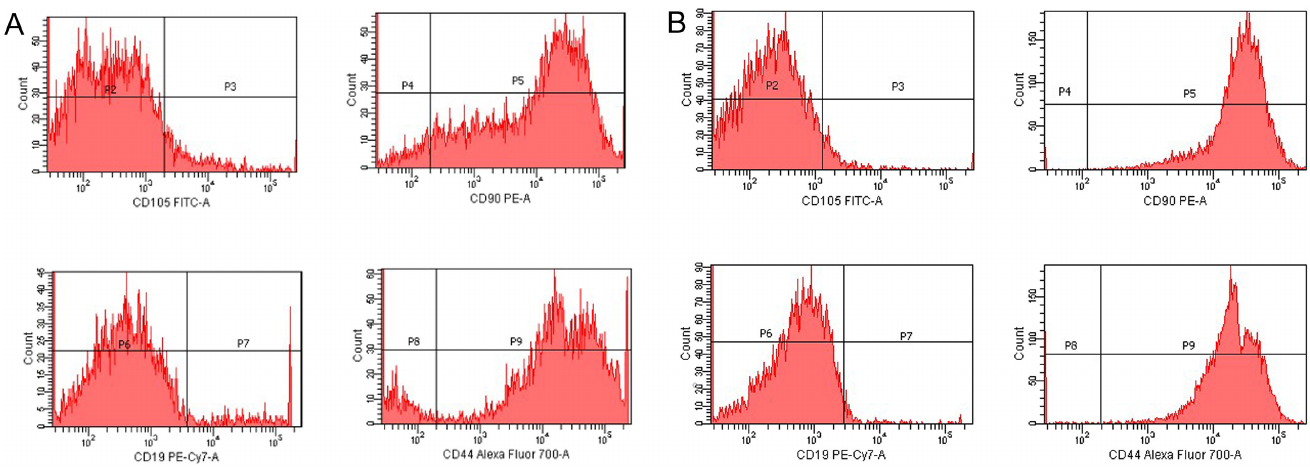
Figure 1. A,B. Characterization of Wharton’s jelly-derived stem cell (A) and adipose tissue-derived stem cell (B) by flow cytometry (analysis of CD90, CD44, CD105, and CD19 cell surface